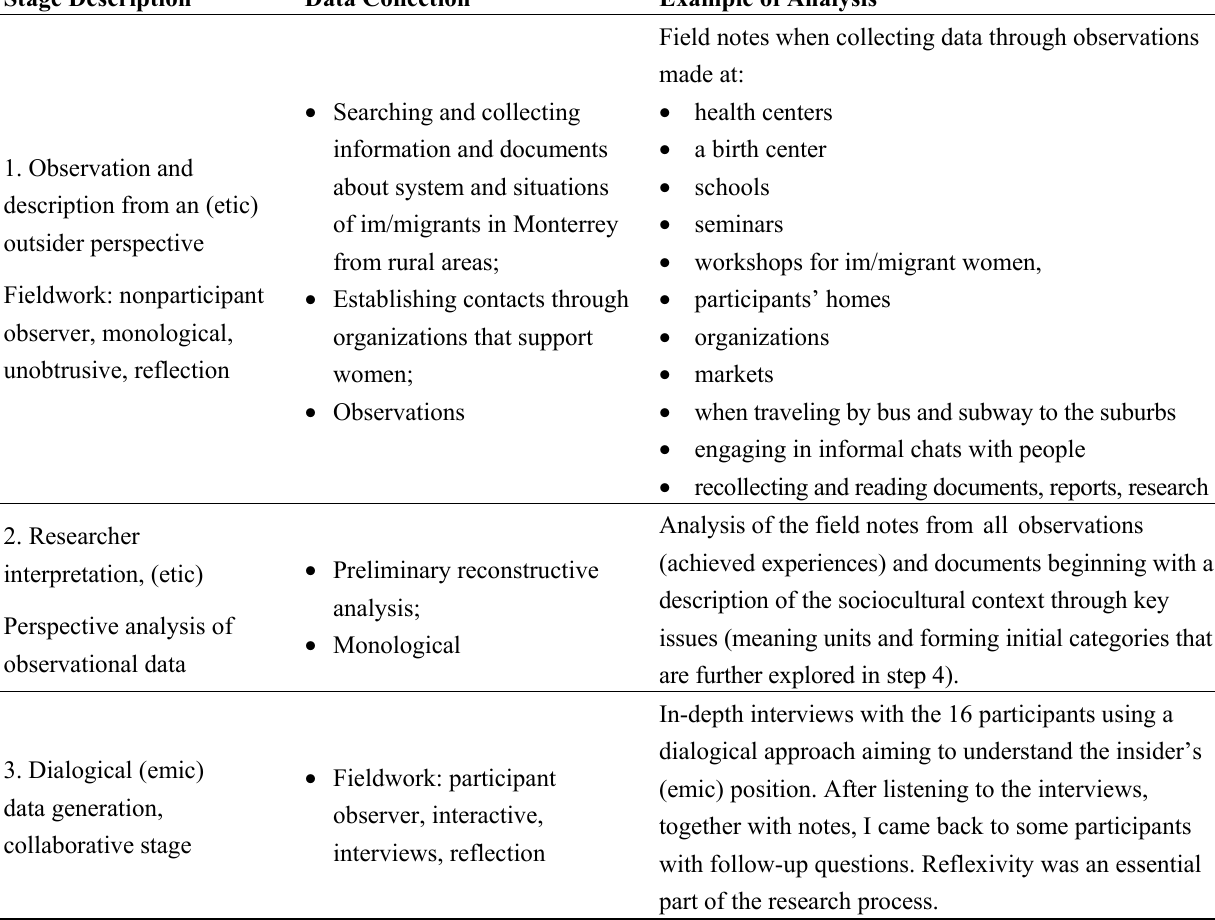
Table 1. An outline of the data